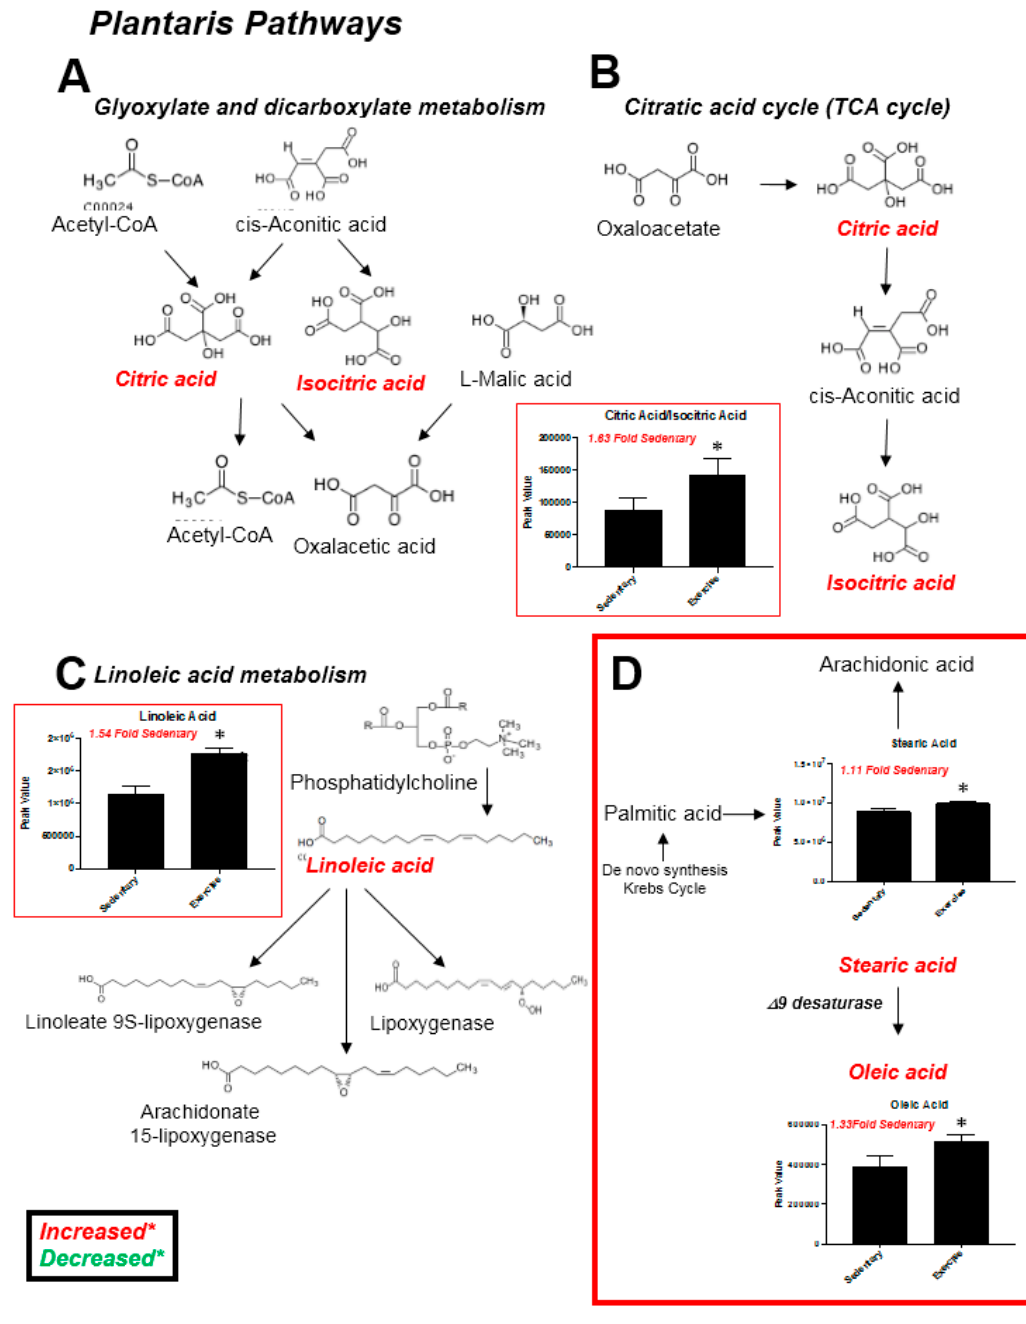
Figure 4. Pathway analysis of t -test significant metabolites. ( A ) Glyoxylate and dicarboxylate metabolism. ( B ) Citric acid (TCA) cycle. ( C ) Linoleic acid metabolism. ( D ) Long-chain fatty acid synthesis. Data represent mean ± SEM. * P < 0.05. N = 12/group.